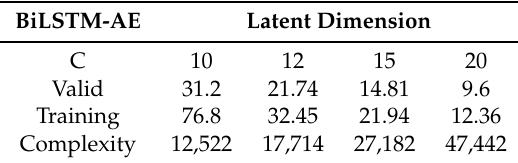
Table 4. Loss values of Bidirectional LSTM AE Training.